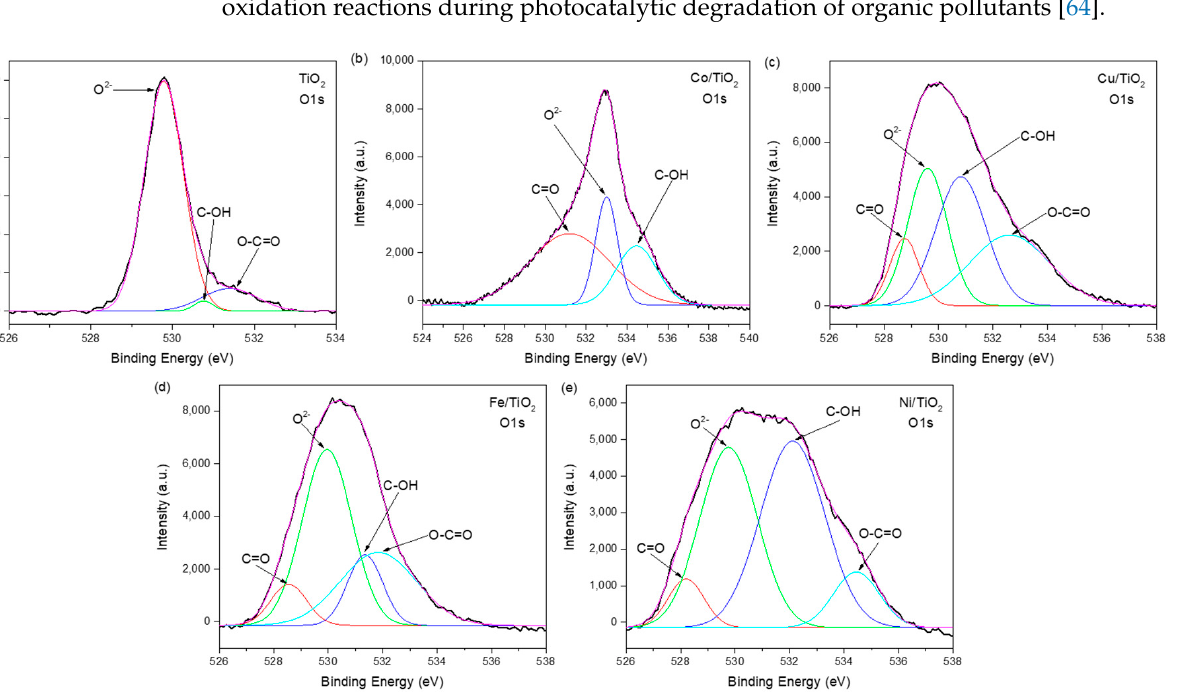
Figure 11. C1s XPS spectrum of: ( a ) TiO 2 , ( b ) Co/TiO 2 , ( c ) Cu/TiO 2 , ( d ) Fe/TiO 2 and ( e ) Ni/TiO 2 .